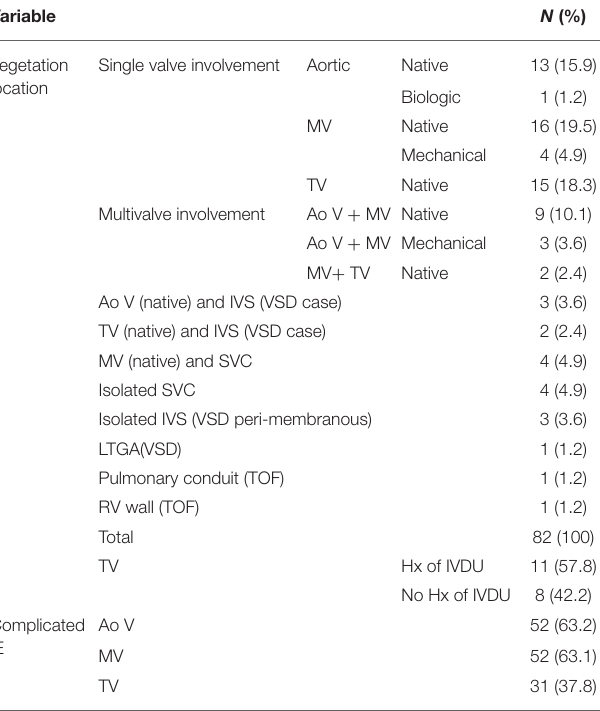
TABLE 3 | Echocardiographic